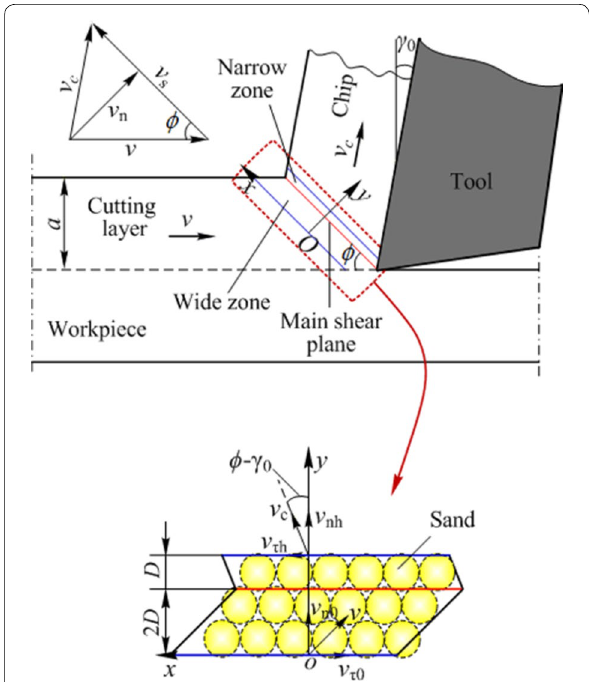
Figure 2 Unequal division shear zone model of sand